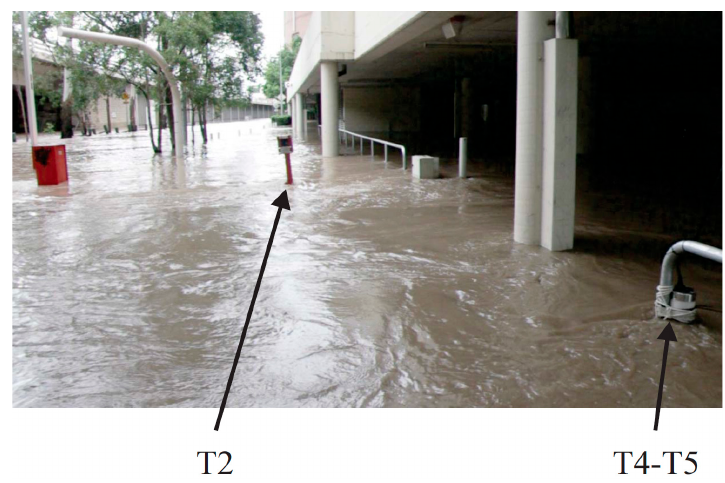
Figure 4. Velocity measurement locations along Gardens Point Road in Brisbane Central Business District, Australia on 13 January 2011 at 11:40. Looking upstream at the acoustic Doppler velocimeter (ADV) sampling sites during periods T2 & T4—T5. The water depth was about 1 m at the time of photograph.